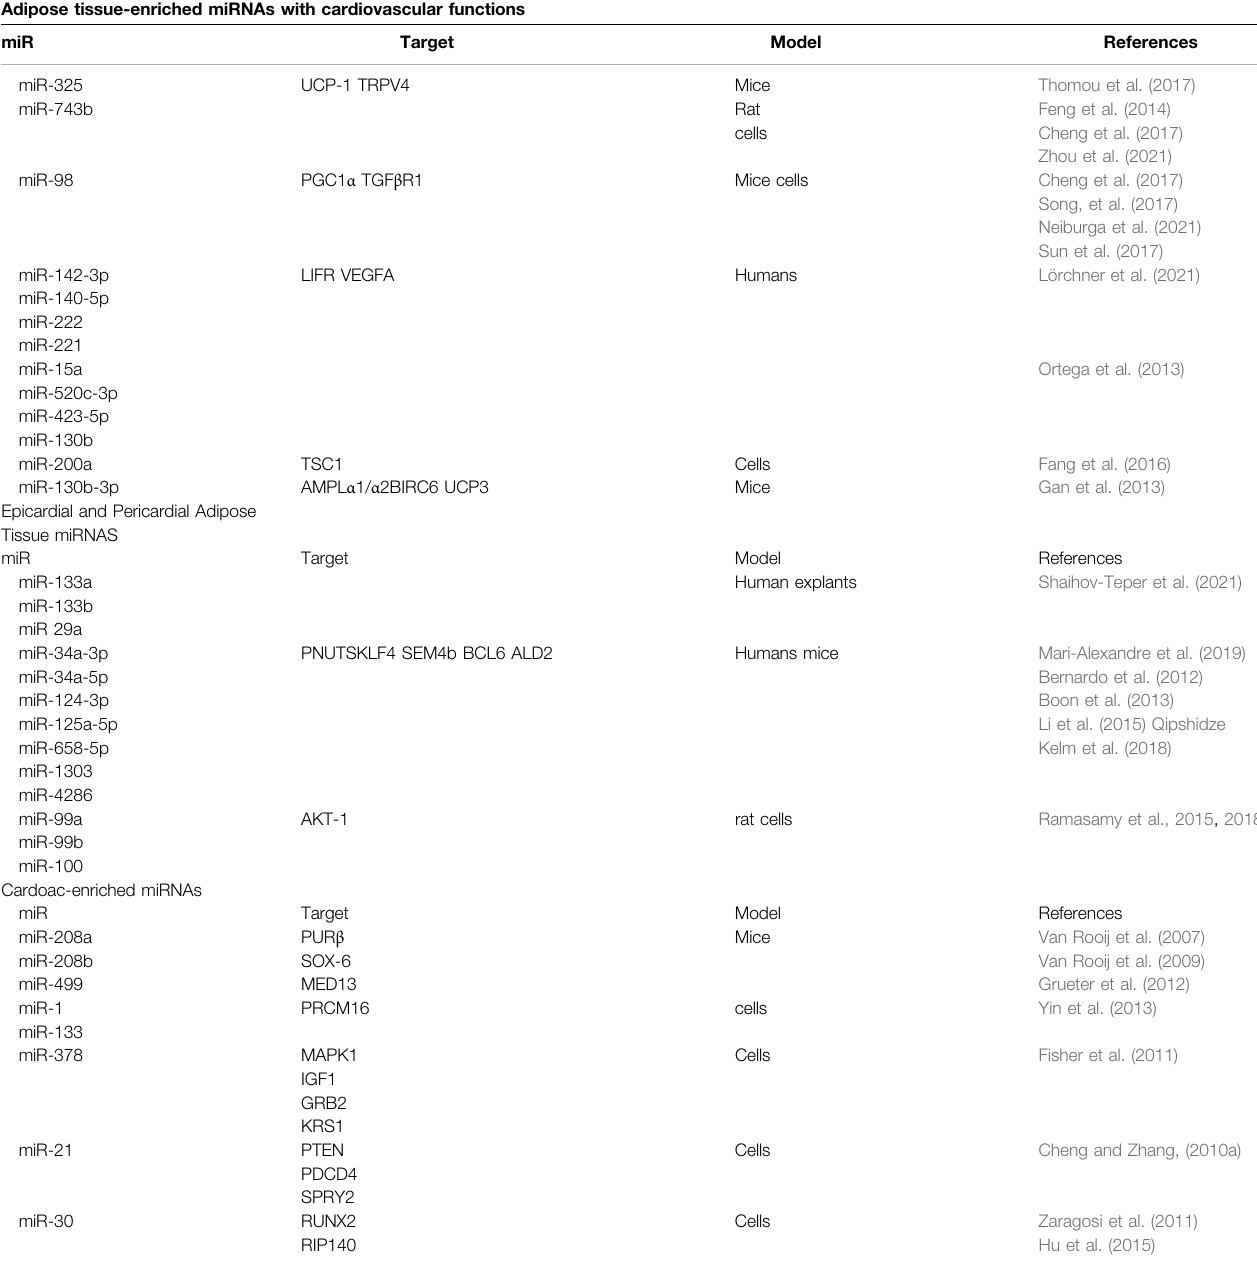
TABLE 1 | miRNAs secreted by adipose tissue and heart and targets potentially involved in bidirectional crosstalk. Adipose tissue-enriched miRNAs with cardiovascular